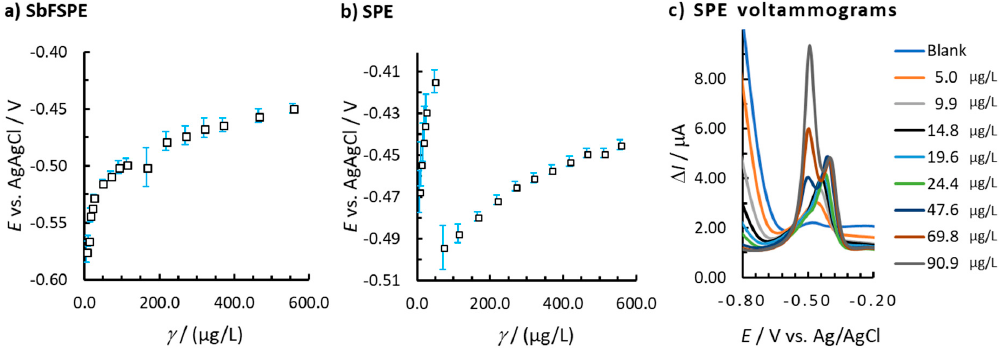
Figure 3. ( a ) The change in peak potential vs. Pb(II) concentration for ( a ) SbFSPE and ( b ) bare SPE. ( c ) the corresponding voltammograms for bare SPE; the error bars represent the standard deviation. The same experimental conditions were employed as in Figure 2.